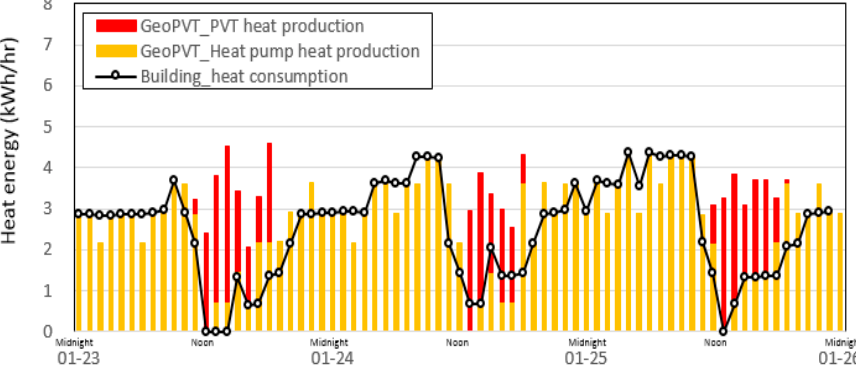
Figure 18. The heat production of the Geo-PVT system during the representing 3-day period.